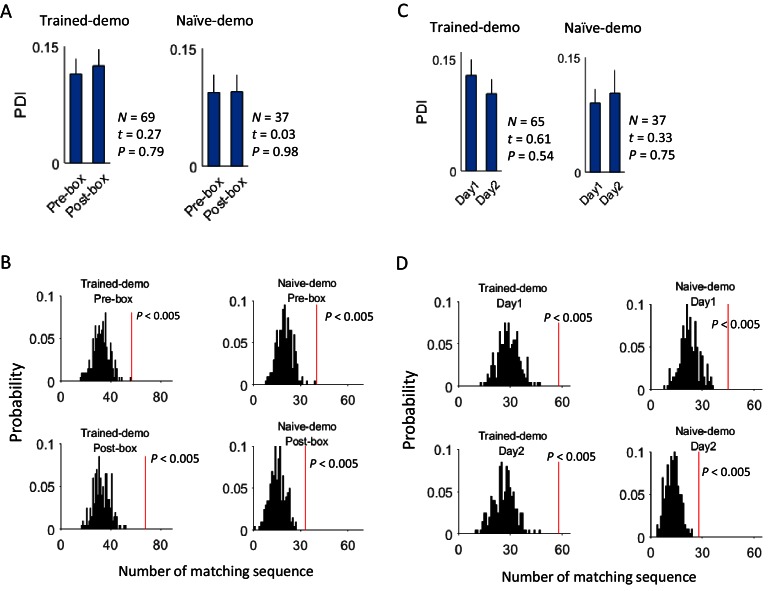
Cross-activation of CA1 activities displayed little experience-dependence.(A) Average PDIs of rotation-active cells for Pre-box and Post-box sessions under Trained-demo and Naïve-demo. N: number of pairings between Pre- or Post-box sessions and track trajectories sessions; t, P: paired t-test statistics and p value. (B) Actual number of matching sequences (red line) relative to the distribution of randomly-generated number of matches (black histogram) in Pre-box and Post-box under Trained-demo and Naïve-demo. P: significance p-values. (C, D): Same as in A, B, but for the first and second recording day (Day1, Day2) under Trained-demo and Naïve-demo.